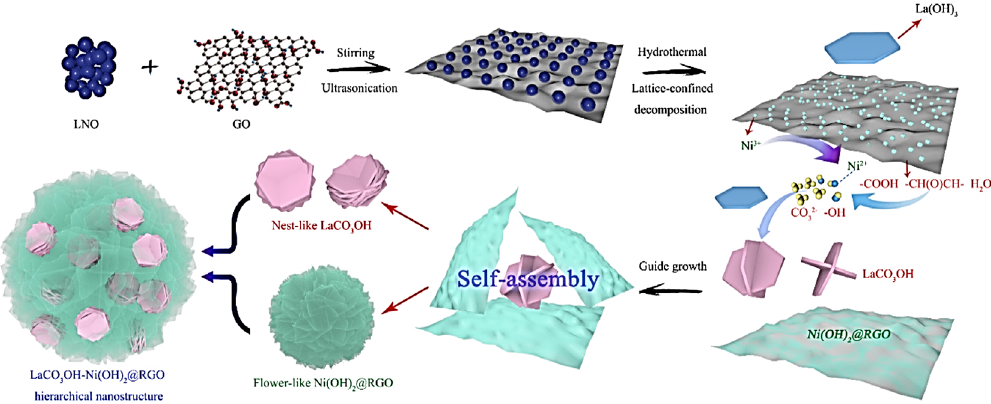
Figure 13. Scheme showing the fabrication of LaCO 3 OH-Ni(OH) 2 @RGO composite. Copyrights 2020 Elsevier [136].